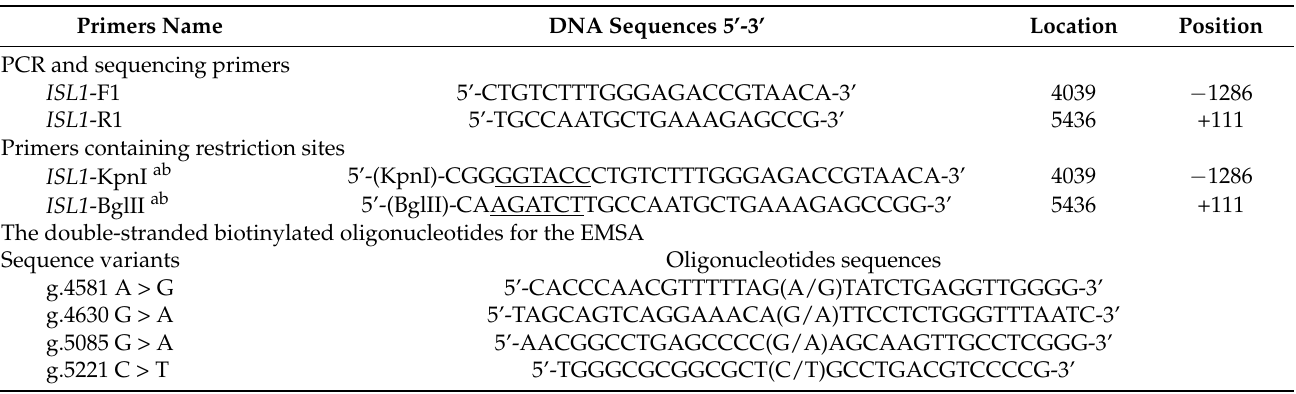
Table 1. List of primers and oligonucleotides sequences for EMSA in this